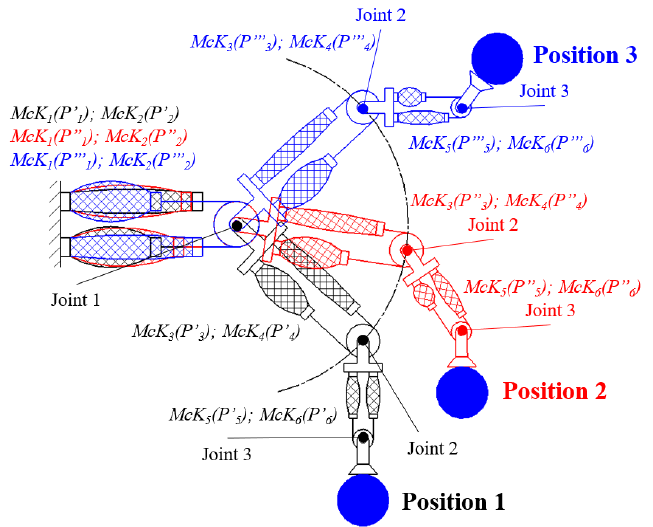
Figure 1. Scheme of an anthropomorphic robotic arm powered by McKibben pneumatic muscles. Different configurations of the muscles of the same joint are required to reach several positions.